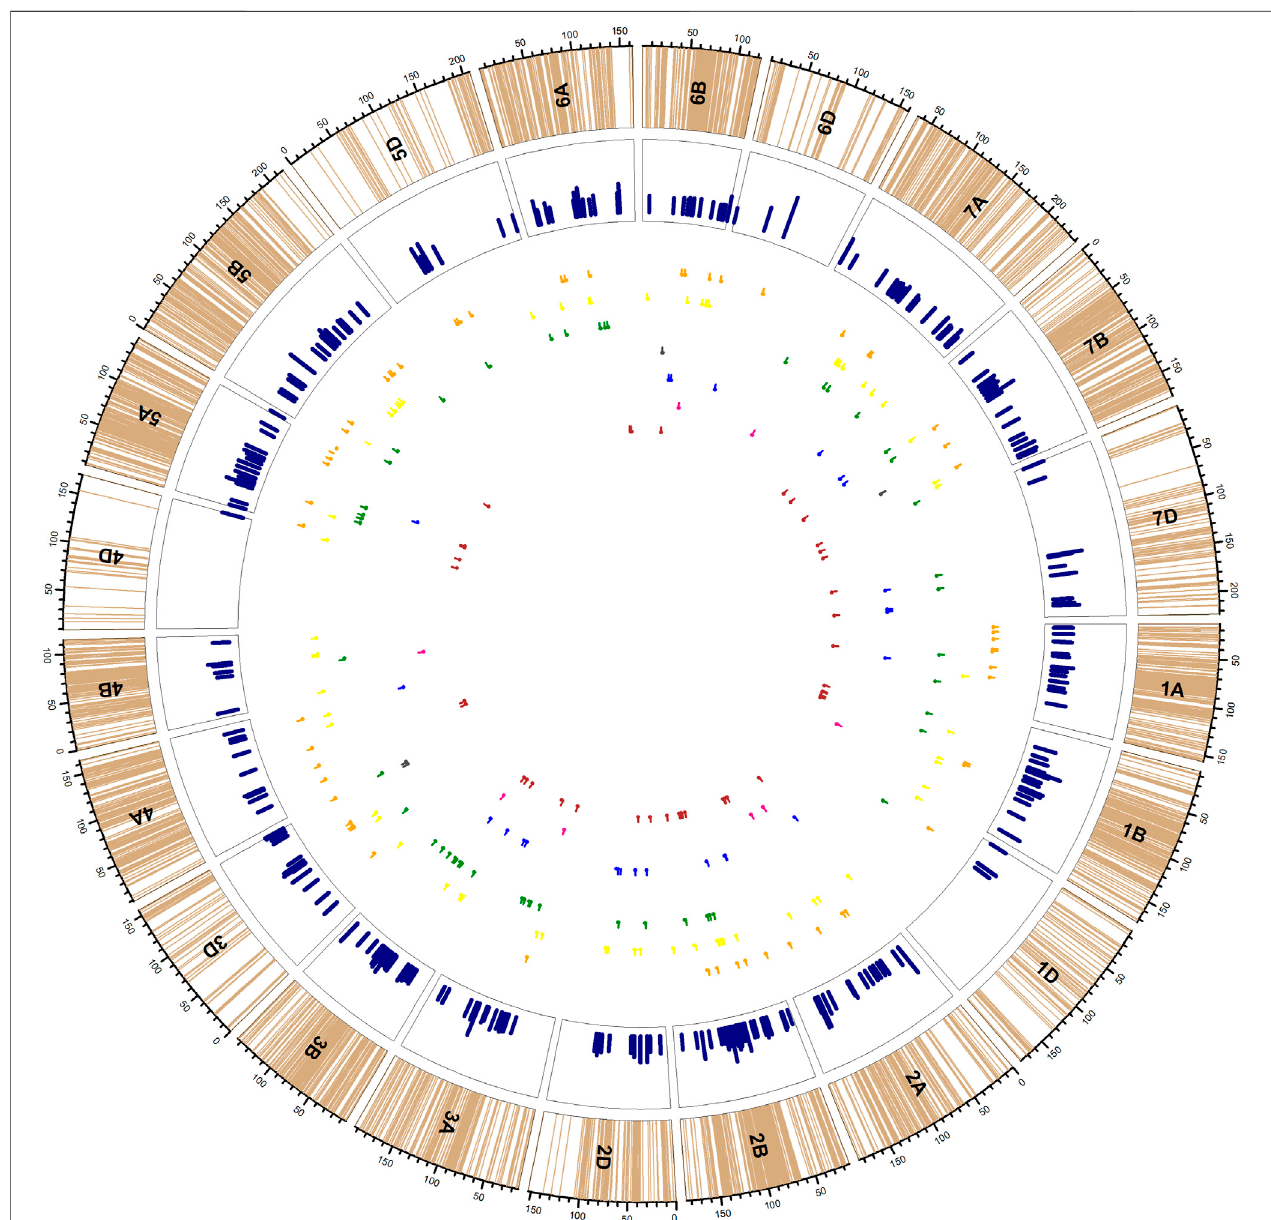
FIGURE 3 | Distribution of 246 QTLs [yellow (yellow wheat blossom midge), orange (orange wheat blossom midge), green (yellow/orange wheat blossom midge), black (saddle gall midge), blue (thrip), pink (frit fl y) and maroon (mixed pests)] in the inner circles. Light brown lines in the outer track indicate the SNP positions on each chromosome;pinkbarsinthesecondcircleindicatethemaximumR2providedbyanySNPcon fi dedtothatQTL.Thecorrespondinglinesunderthetrackcircleindicate the span of QTLs for respective traits with small vertical lines point to the peak position of QTL.